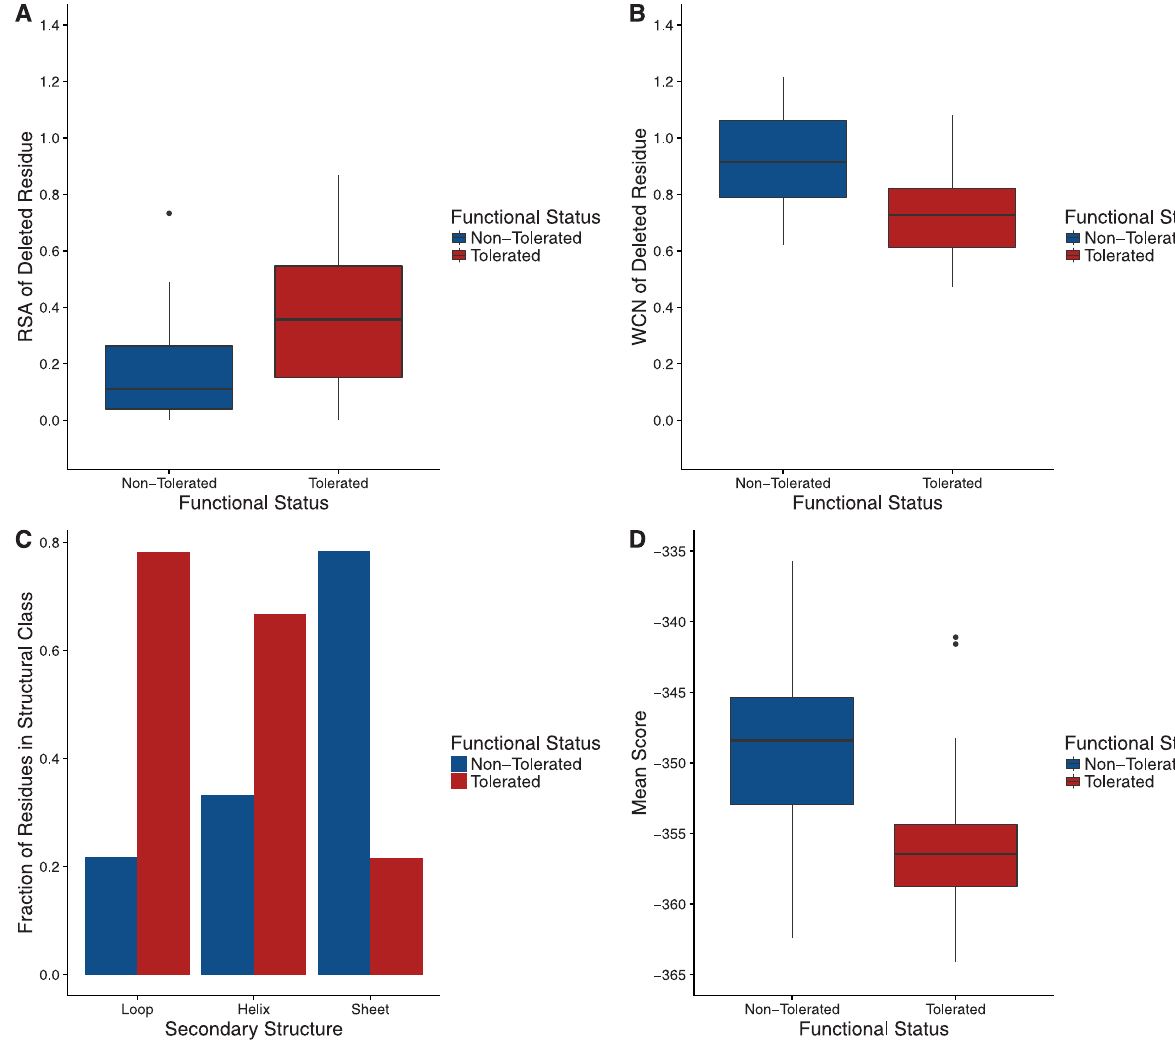
Fig 3. Structural properties of functional and non-functional deletions. (A) Distributionof RSA among deletions. On average, residues with tolerated deletionsare more exposedthan residueswith non-tolerated deletions( t test, P = 1.030 × 10 − 3 ). (B) Distributionof WCN amongdeletions. On average, residueswith tolerated deletionshave lower WCN than residues with non-tolerated deletions( t test, P = 2.998 × 10 − 7 ). (C) Secondary structure of deletions.Non-tolerateddeletions are colored in blue and tolerated deletionsare in red. The majority of the residues deletedin the loop regionsand alpha helix regions are tolerated and result in a functioning fluorescentphenotype. 78.3% and 66.7% of deletedresidues are tolerated in loop and helicalregions, respectively. However, only a small fraction of residues (21.6%) deletedin areas of the proteinsthat make up a beta sheet are tolerated. These relative frequencies are significantly different from each other ( χ 2 contingency table, P = 3.642 × 10 − 5 ). (D) Distributionof mean scores amongdeletions.Residuesthat are tolerant to deletion have lower scores (i.e., more negative)on averagethan non-tolerant residues( t test, P = 2.084 × 10 − 6